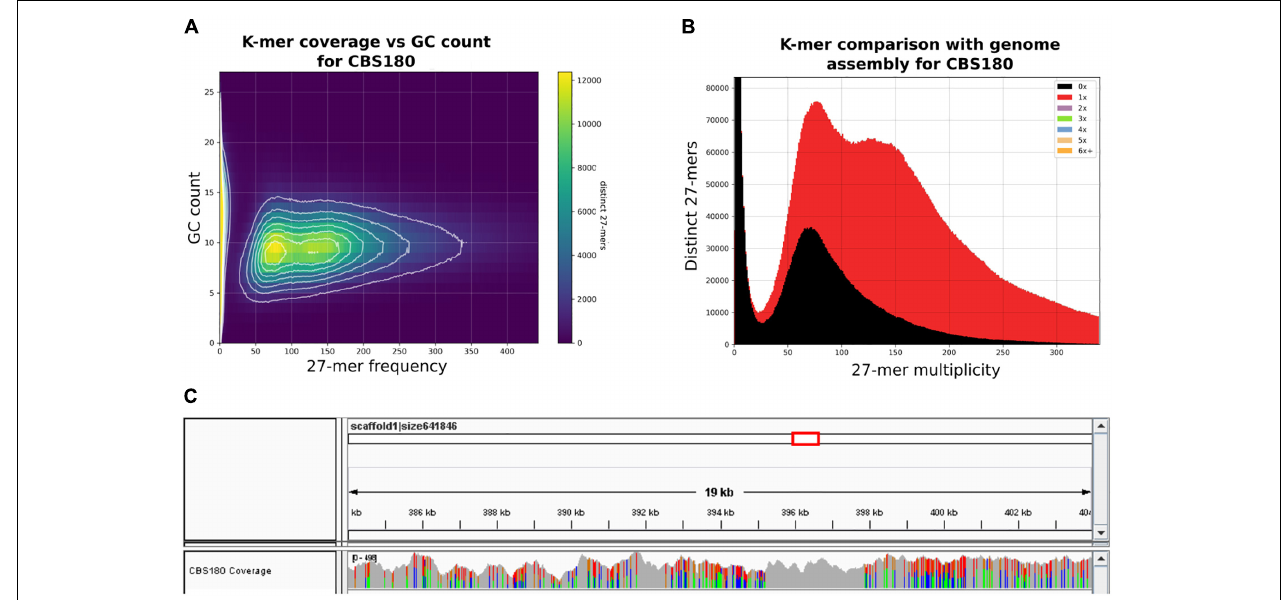
FIGURE 1 | Heterozygosity patterns in Candida inconspicua type strain genome. (A) 27-mer frequency in CBS180 genomic reads and respective GC content. (B) 27-mer frequency in CBS180 genomic reads and indication of their presence (red) or absence (black) in the genome assembly. Although both 27-mer count peaks were represented in the genome assembly, roughly half of the reads corresponding to the first one was excluded. These reads probably correspond to redundant heterozygous contigs that were intentionally removed during the reduction step of the assembly process (see section “Materials and Methods”). (C) IGV coverage track of a 19 kb region of C. inconspicua scaffold 1. Colors represent polymorphic positions. Highly heterozygous regions are clearly interspaced by blocks of loss of heterozygosity (LOH).